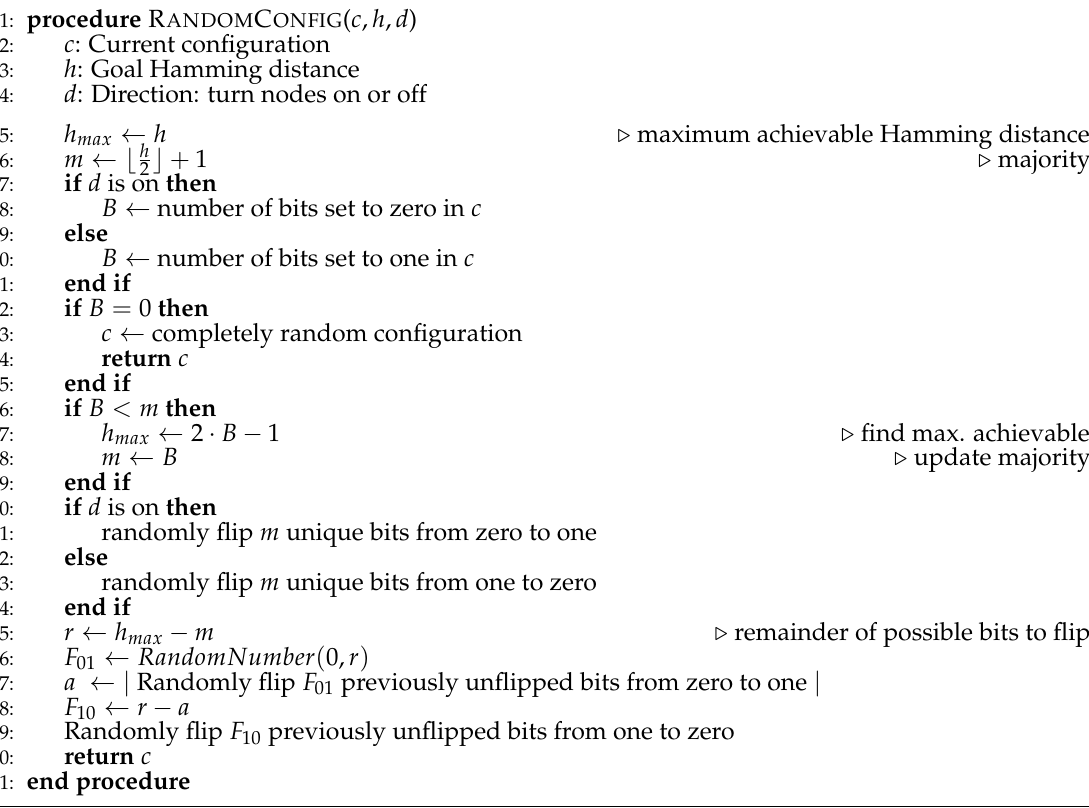
Algorithm 2 Random